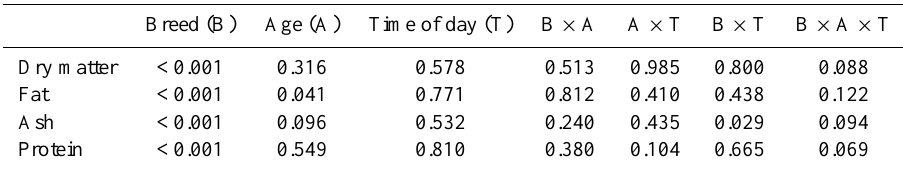
Table 3. t test and analysis of variance regarding the effect of breed, age and time of day on proximate composition ( P values of independent variables and